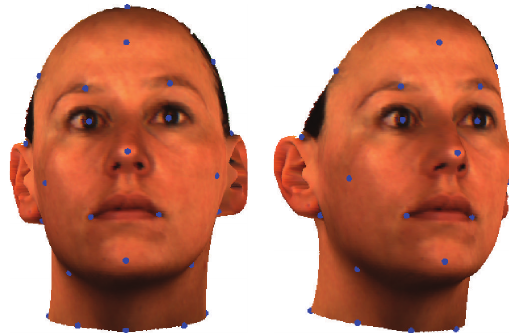
Figure 1: The landmarks placed on the 3D faces for TPS transformation using an interactive tool.